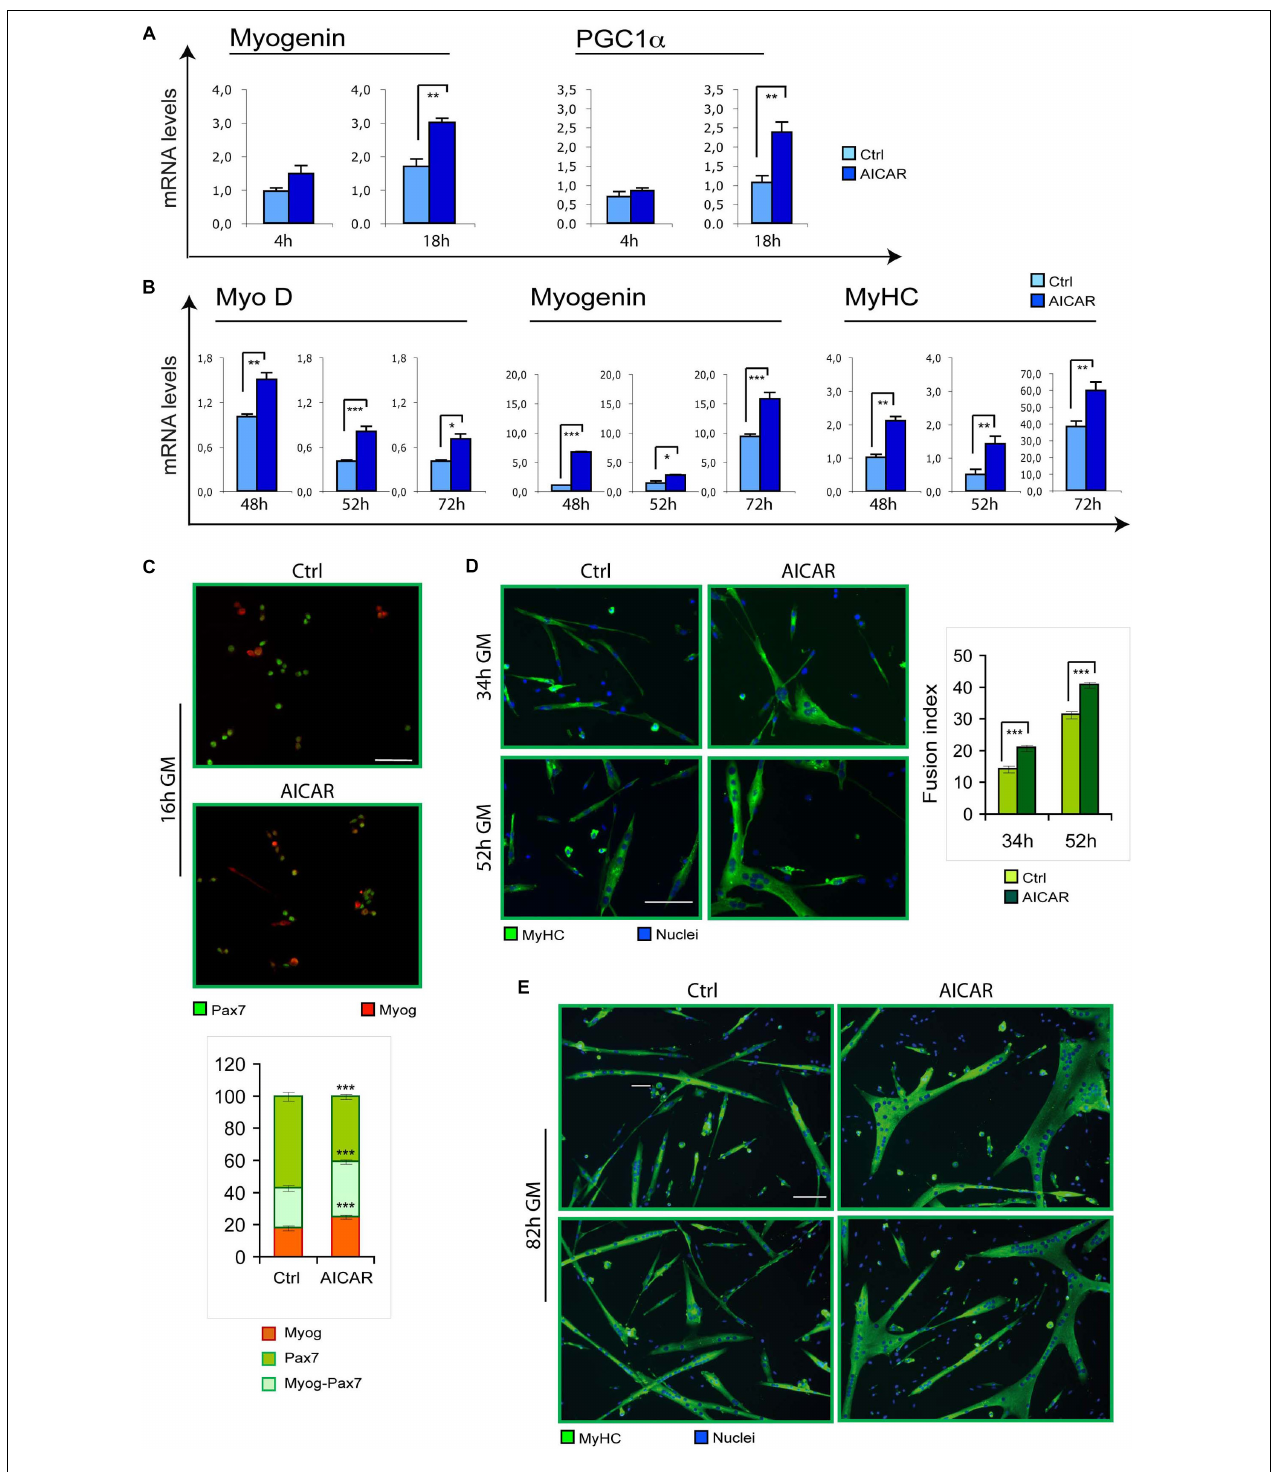
FIGURE 2 | Similarly to TMZ, also AICAR stimulates myogenic differentiation. (A) The mRNA levels of Myogenin and PGC1a were evaluated by quantitative real time PCR in C2C12 myoblasts differentiating for 4 and 18 h with or without 0.5 mM AICAR. The mRNA expression values were normalized to those of 18S ribosomal RNA, used as internal control, and are displayed as folds relative to a plate reference control sample (0 h in differentiation medium, not shown). Data shown are the mean ± SEM from four experiments each performed in triplicate. ∗∗ p ≤ 0.01 by two-tailed Student’s t -test. (B) The mRNA levels of MyoD, Myogenin, and MyHC were evaluated by quantitative real time PCR in primary satellite cells cultured for 24 h and then treated with 0.5 mM AICAR for further 24 h (total 48 h in culture), or